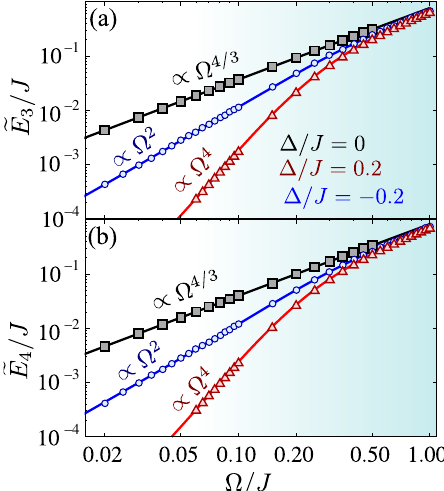
~ E given by the N